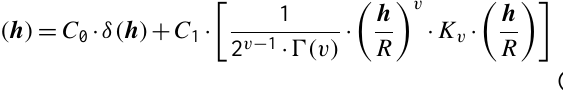
Fig. 2. The uncertainty of deriving stream can be best described using the information entropy ( H ) of a Bernoulli trial. This plot is courtesy of Brona Brejova, Comenius University in Bratislava,